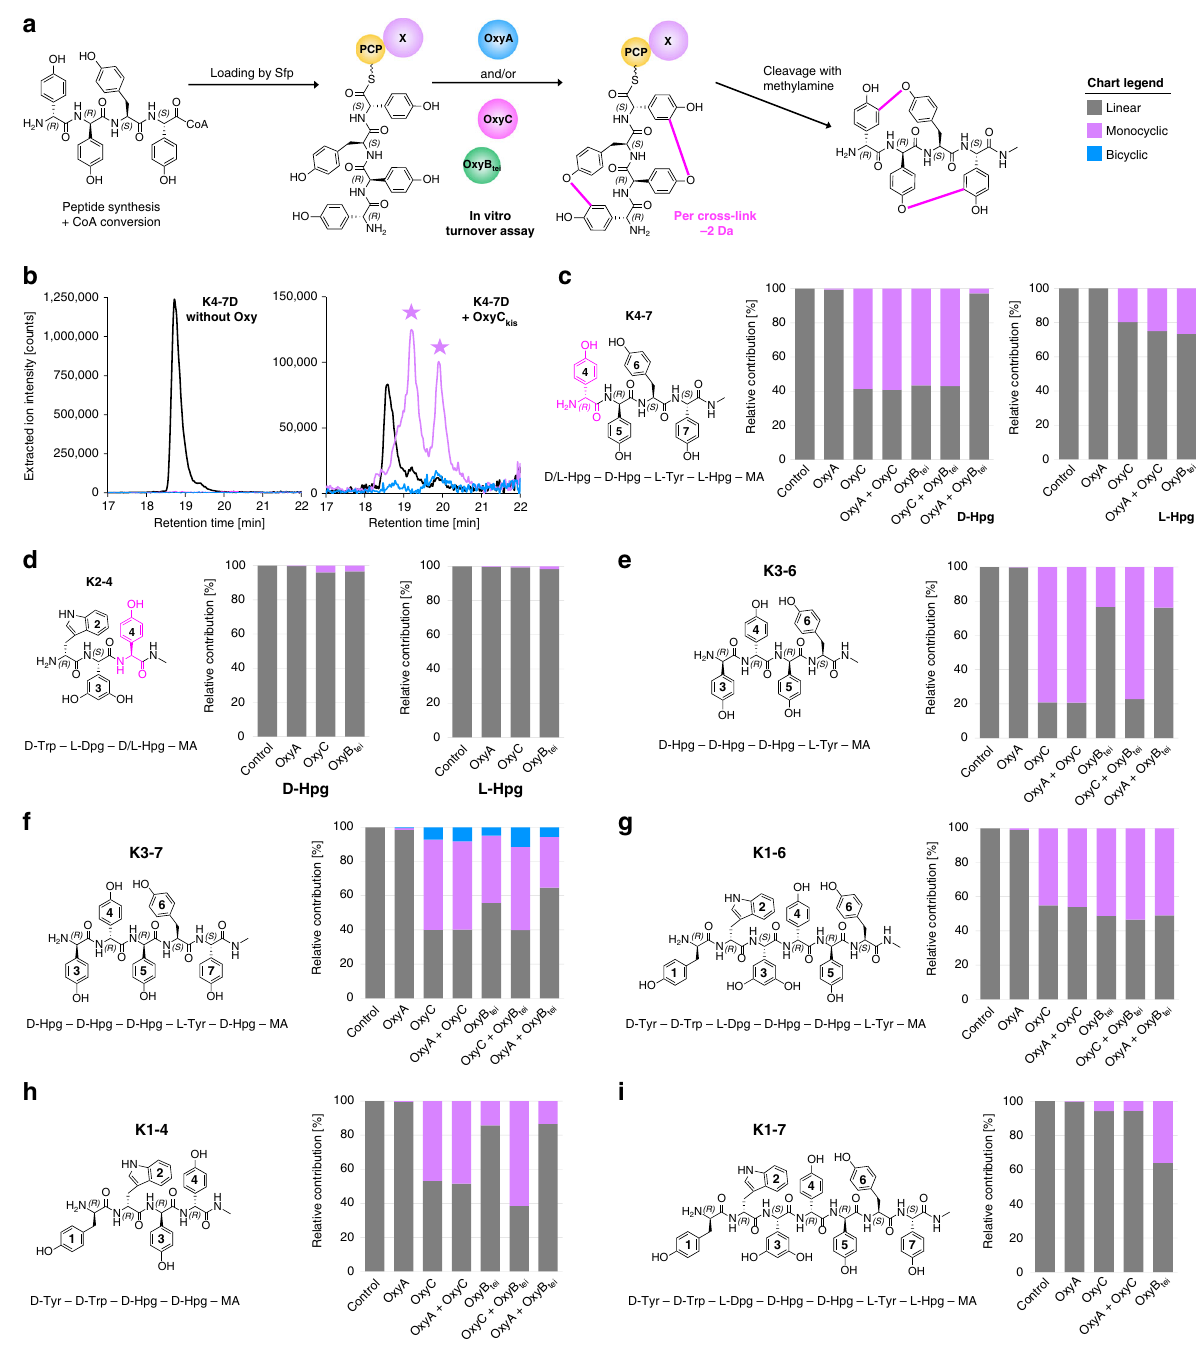
Fig. 7 In vitro reconstitution of kistamicin Oxy enzymes. a Schematic illustration of in vitro reaction: kistamicin peptides were synthesised on hydrazine resin and converted into their CoA thioesters that were then loaded into the PCP-X kis didomain by the phosphopantetheinyl transferase Sfp. After incubation with OxyA kis , OxyC kis and/or OxyB tei (different combinations), the peptide was cleaved from the PCP by the addition of methylamine and subsequently analysed by HPLC-MS. b Example shown for the peptide K4-7D: in the control reaction, only linear peptide is detected. Reactions containing OxyC kis led to the formation of several monocyclic products and traces of bicyclic compounds. Structures of synthesised peptide probes and turnover results of c K4-7 (4-D) (left) and (4-L) (right), d K2-4 (4-D) (left) and (4-L) (right), e K3-6, f K3-7, g K1-6, h K1-4 and i K1-7. Detection of linear peptide mass is indicted in dark grey, of monocyclic compound in purple and bicyclic compound in blue. Source data are provided as a Source Data fi